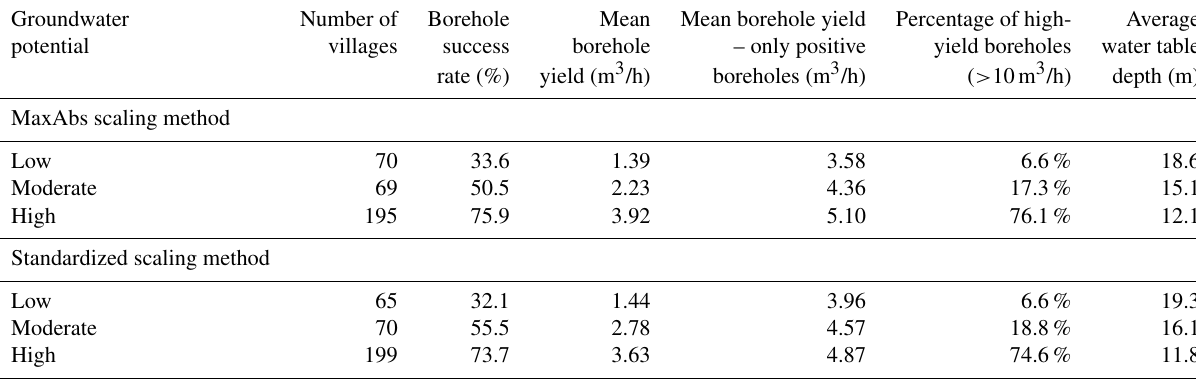
Table 4. Results of the analysis based on the agreement map categories for the MaxAbs and standardized scaling methods. The analysis was performed for villages with more than five wells. The average success rate, average flow rate, average flow rate without negative boreholes, percentage of wells with a yield higher than 10m 3 /h and the average water table depth are